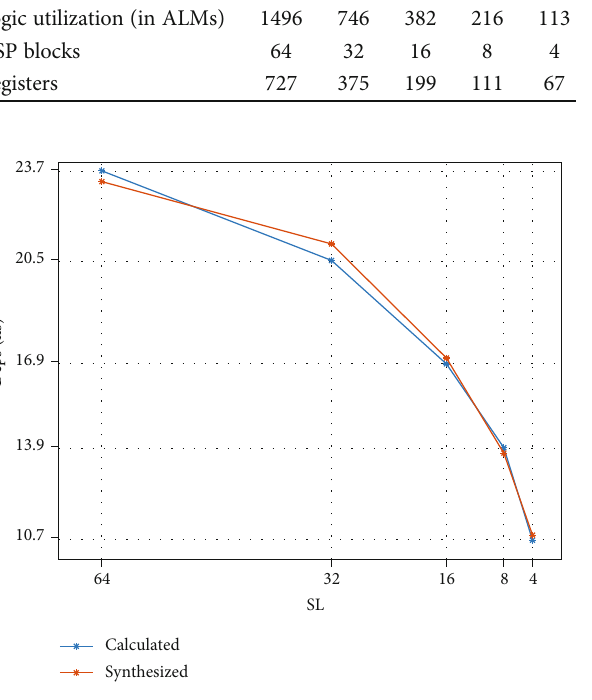
Figure 10: Propagation delay of the segmented inner-product.